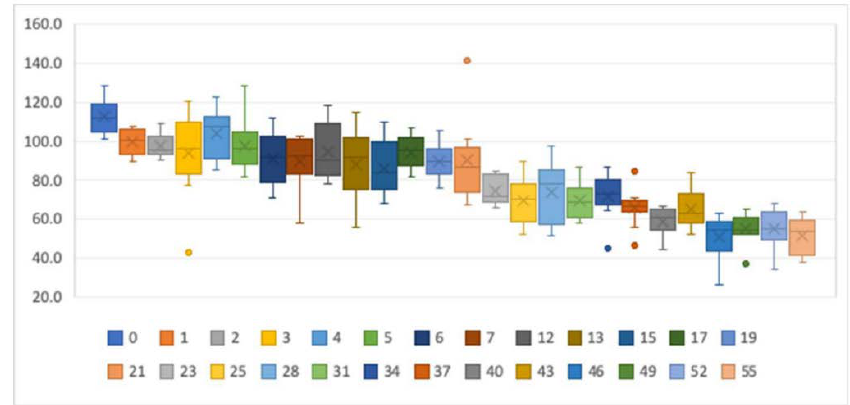
Figure 2. Boxplots showing the tT 4 stability for di ff erent storage times. y -axis: percentage of initial tT4 concentrations. x -axis: storage time in weeks. The dots represent outliers.